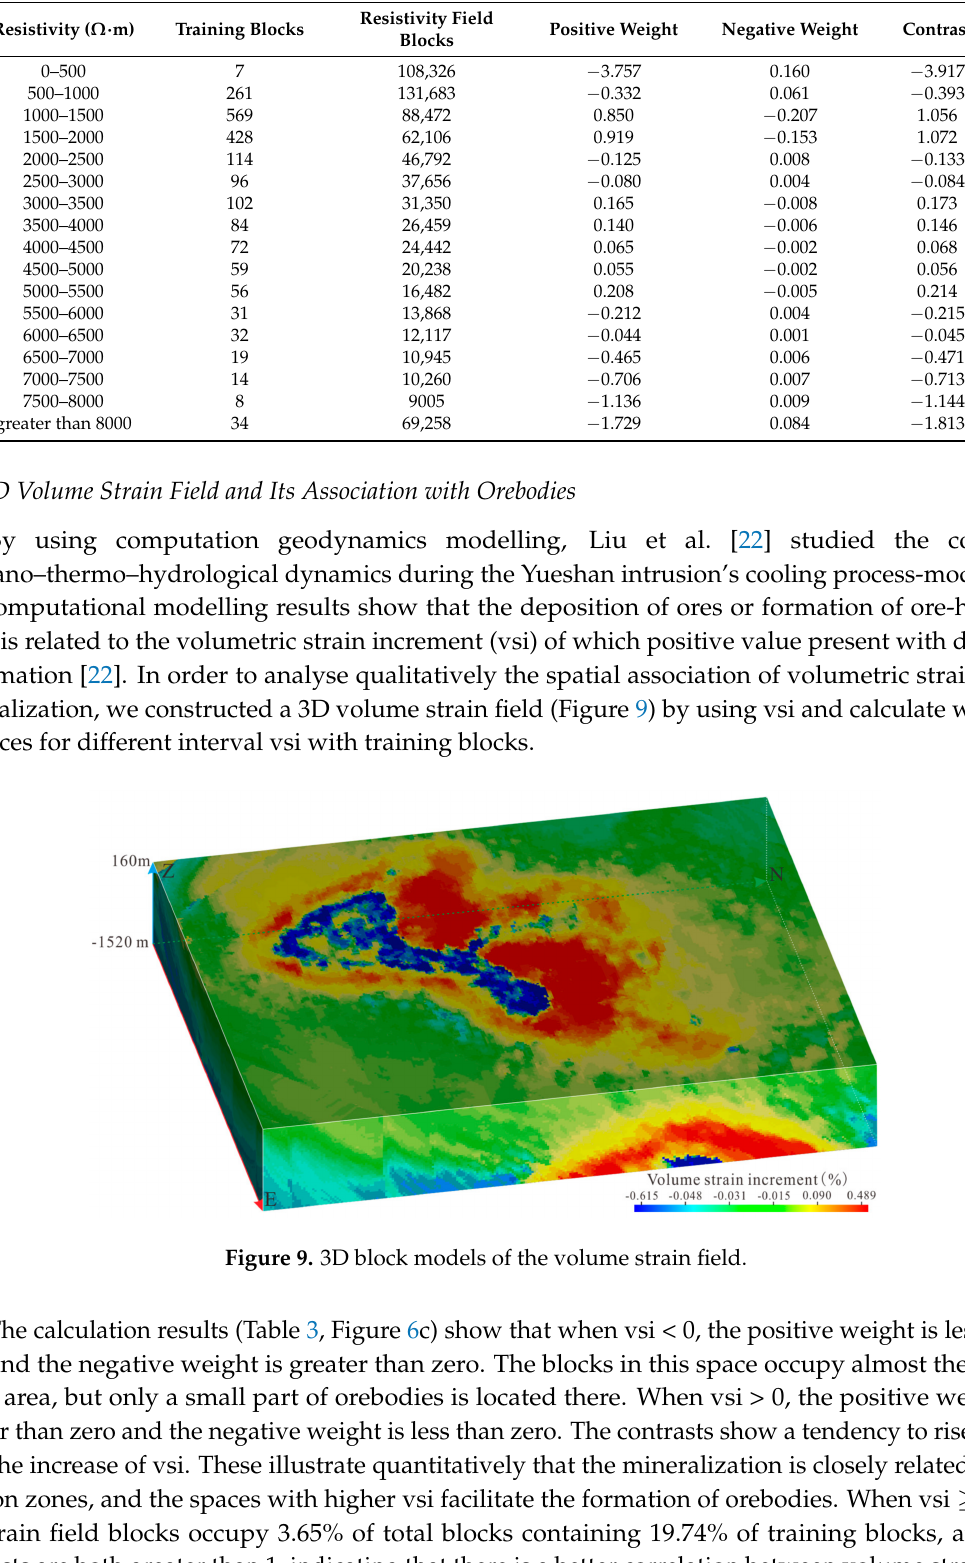
Table 2. Weights for different spaces of resistivity field at 500 Ω · m intervals.